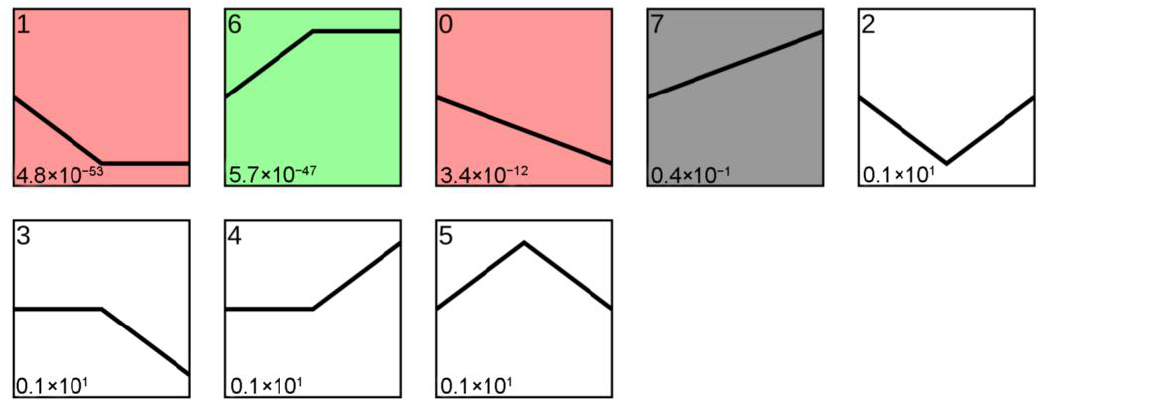
Figure 4. Different expression clusters of lncRNAs ad mRNAs. ( A , B ) The numbers in the left upper part of the boxes indicate profile IDs (0–7), whereas those in the left lower part of the boxes indicate p -values. The boxes are sorted by p -values, as calculated using a hypergeometric test, with the values presented in ascending order.